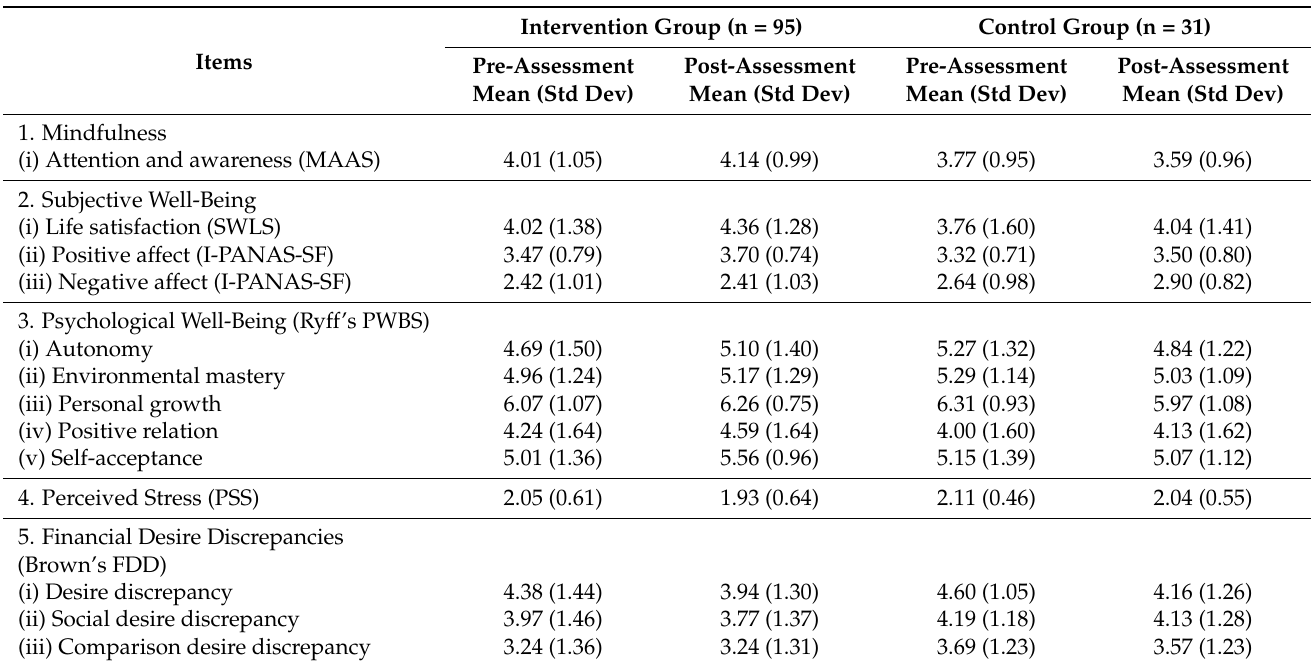
Table 5. Descriptive Statistics of Intervention and Control Groups.